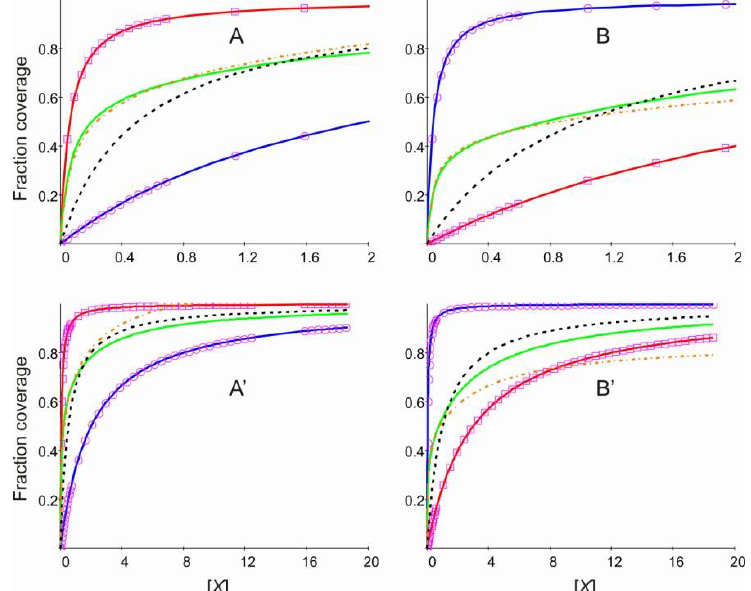
Figure 2. Isotherms expressed as a function of the concentration of [ X ]. Left: Calculated for K 1 = 50.0 and K 10 = 1.0. Right: Calculated for K 1 = 1.0 and K 10 = 50.0. ( A , B ) in the range of [ X ] between 0 and 2, and ( A’ , B’ ) between 0 and 20. Solid lines: Amount of the objects X m { AB } X n . Red: m = 1,2,3, all n ; divided by 3. Blue: { AB } X n , n = 1,2; divided by 2. The rectangles and the circles correspond to Langmuir’s eqs. (29) and (29A) of ref. [1] with K L = K 1 / 3 and K L = K 10 / 2, respectively. Green: all X m { AB } X n , except { AB }, divided by 5. Black, dashed: Isotherm calculated using Langmuir’s eqs. (29) and (29A) of ref. [1] with optimized values for K L . Orange, dash dot: Sum of the red and the blue curves weighted by an optimized